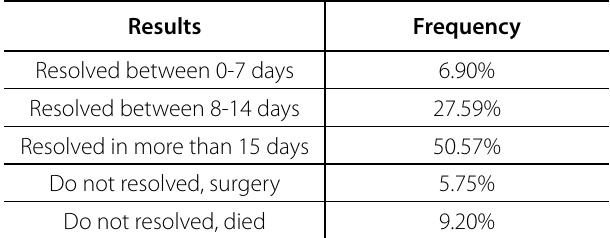
Table 3. Treatment